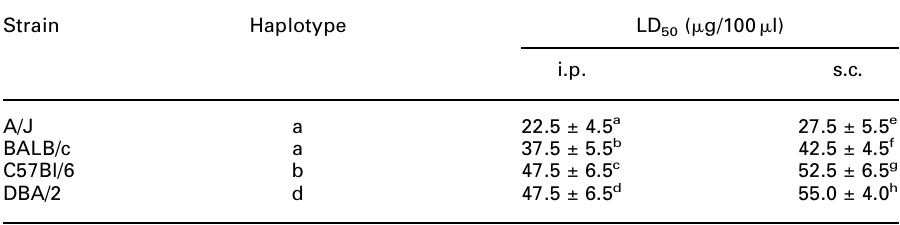
Table 1. Susceptibility to TSV of different strains of isogenic mice